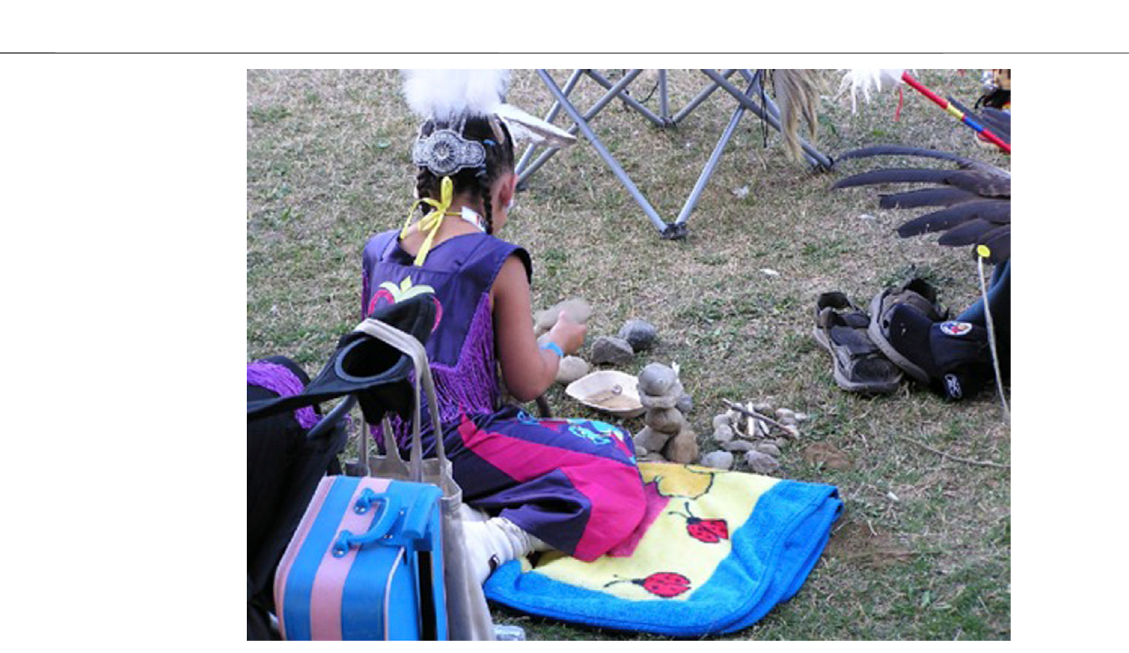
Frontiers in Education |